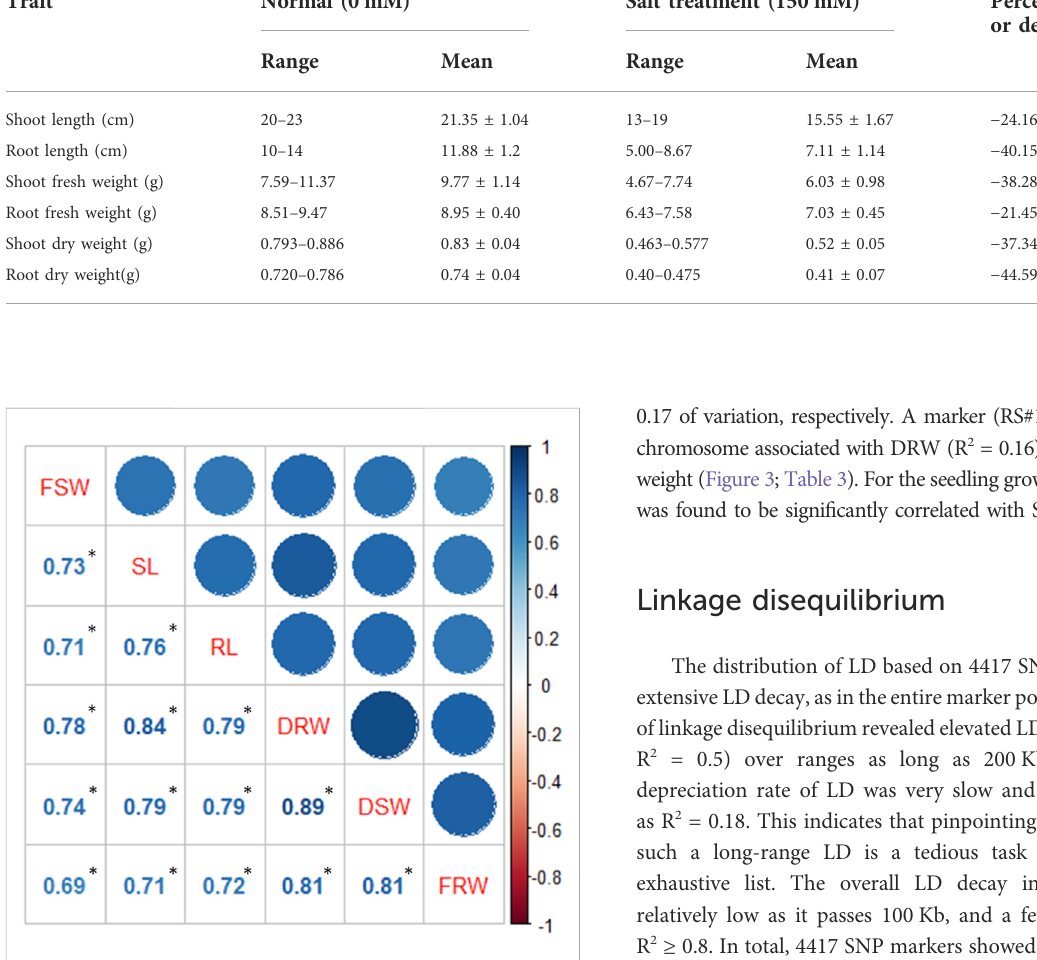
FIGURE 1 Correlation among seedling-related